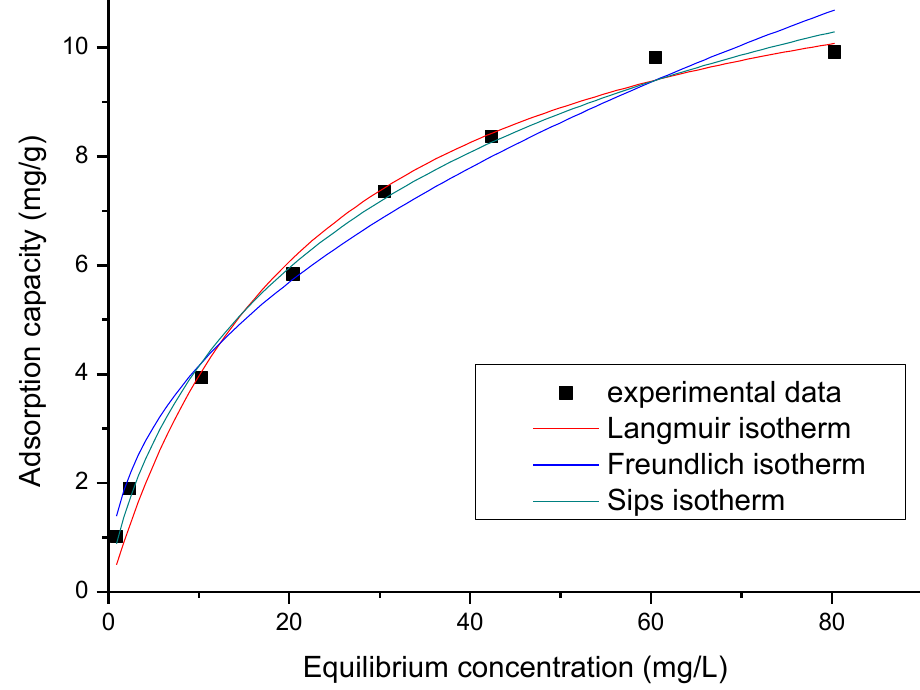
Figure 8. Equilibrium studies.